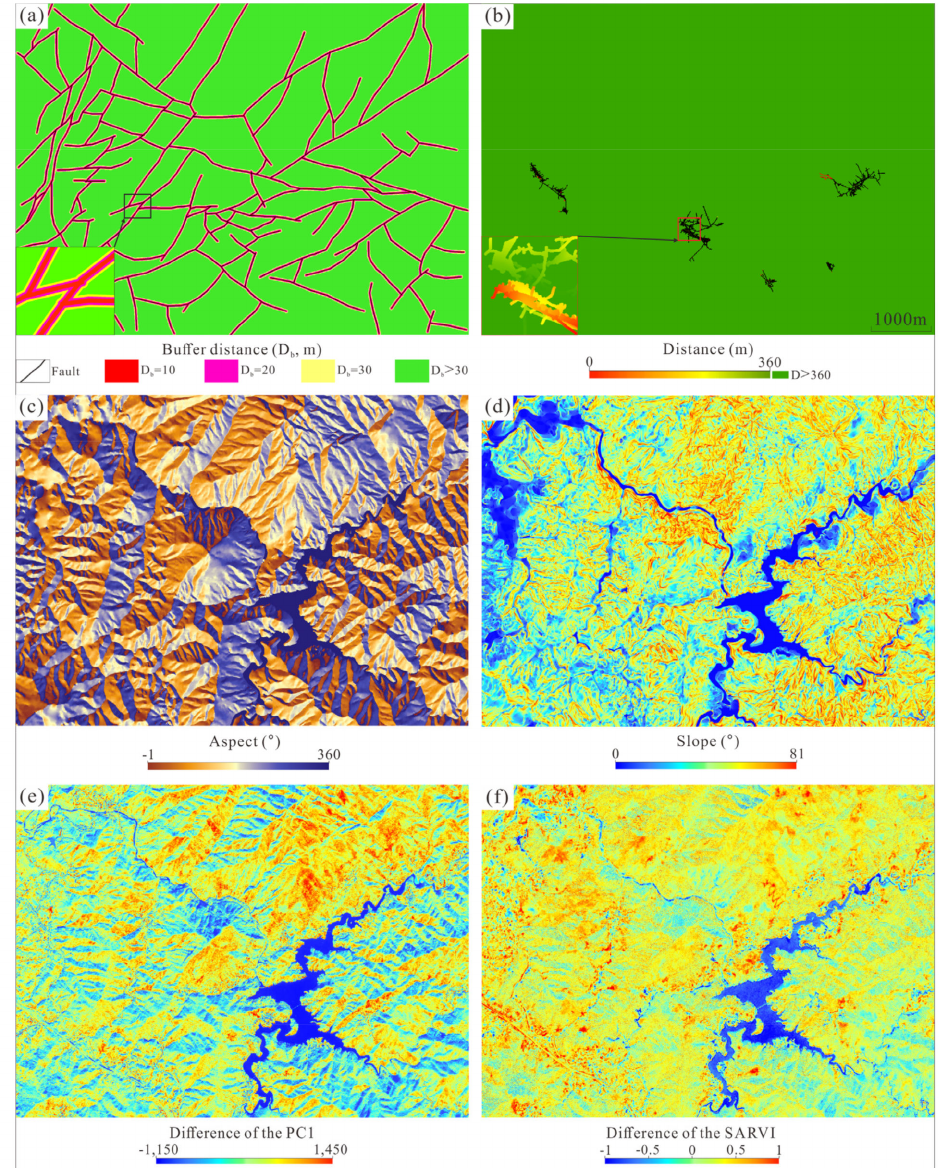
Figure 11. Predictive factor layers: ( a ) distance buffers of the structure, ( b ) difference in elevation between underground excavation and surface, ( c , d ) aspect and slope, and ( e , f ) difference between the PC-1 and